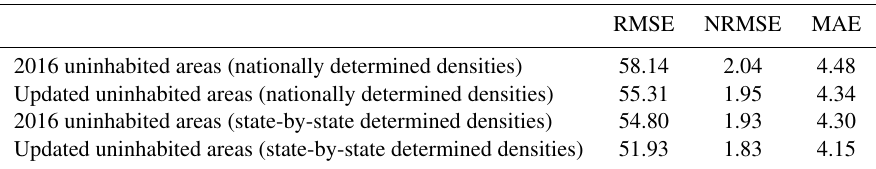
2016 uninhabited areas (nationally determined